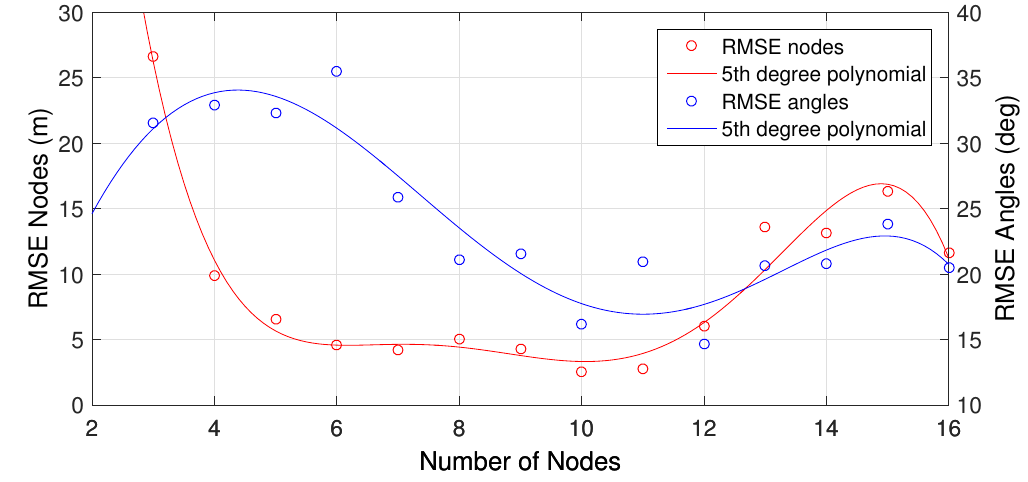
Figure 10. Varying the size of the subset of a constellation with a total of 16